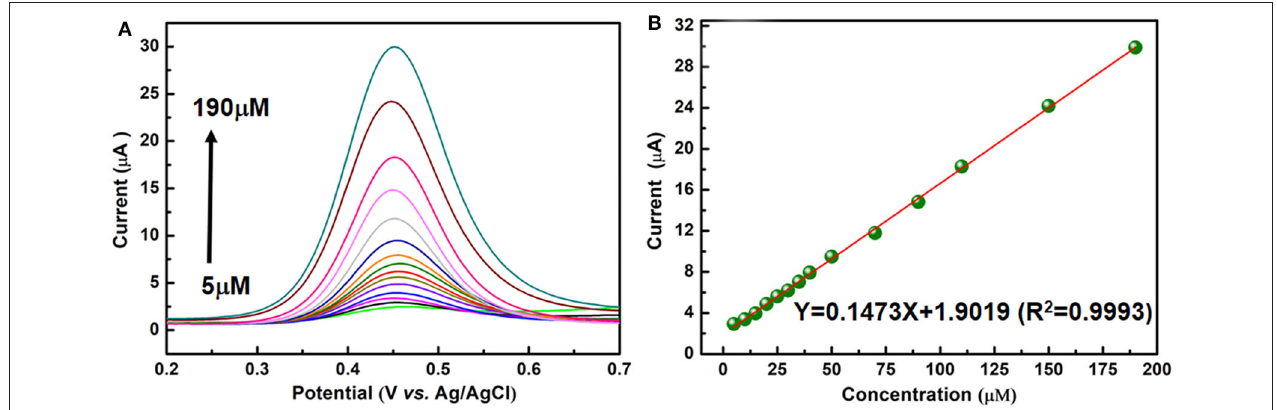
FIGURE 6 | (a) Evaluation of repeatability. (b) Stability of the NiCu-CAT/GCE after pretreatment during 30 days. (c) DPV responses of the NiCu-CAT/GCE in PBS (0.1M, pH 6.5) containing 40 µ M PA and 200 µ M DA; inset is the containing 40 µ M PA and 200 µ M AA, respectively. (d) Effects of the presence of inorganic ions on the voltammetric responses of 40 µ M paracetamol using the NiCu-CAT/GCE.